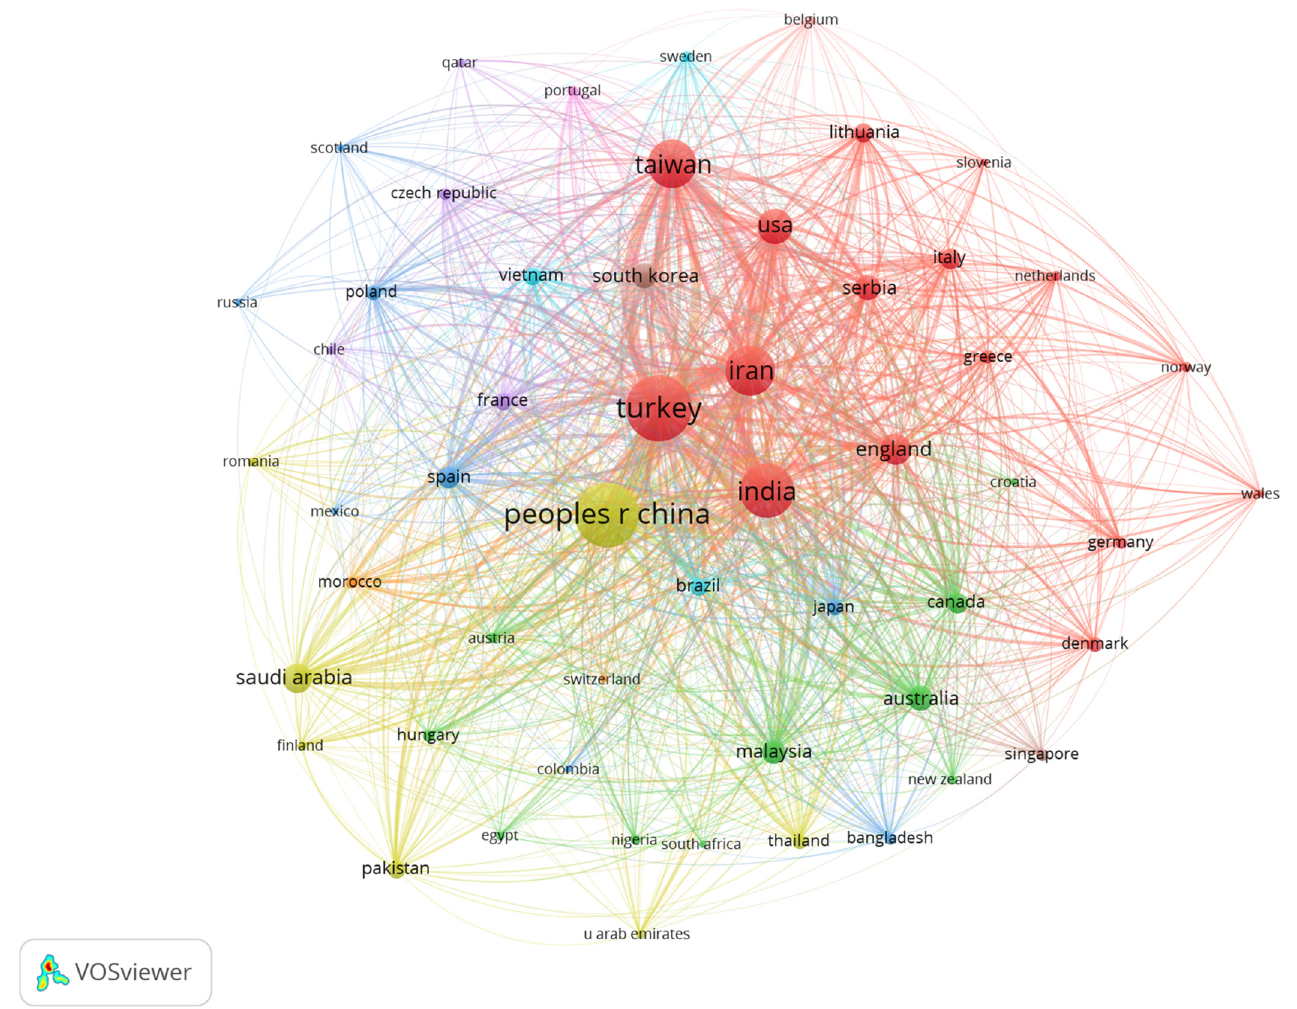
Figure 4. International collaboration networks. Bibliographic coupling of countries. More than five citations per country.